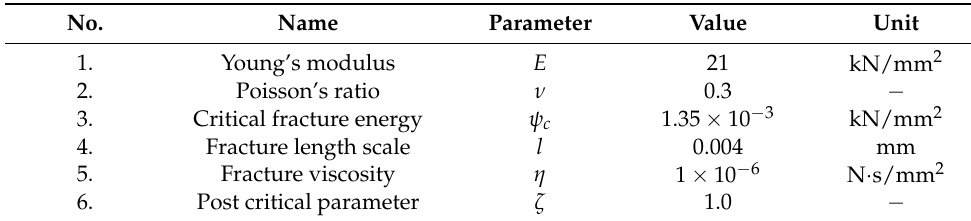
Table 4. Material parameters used in the numerical examples.